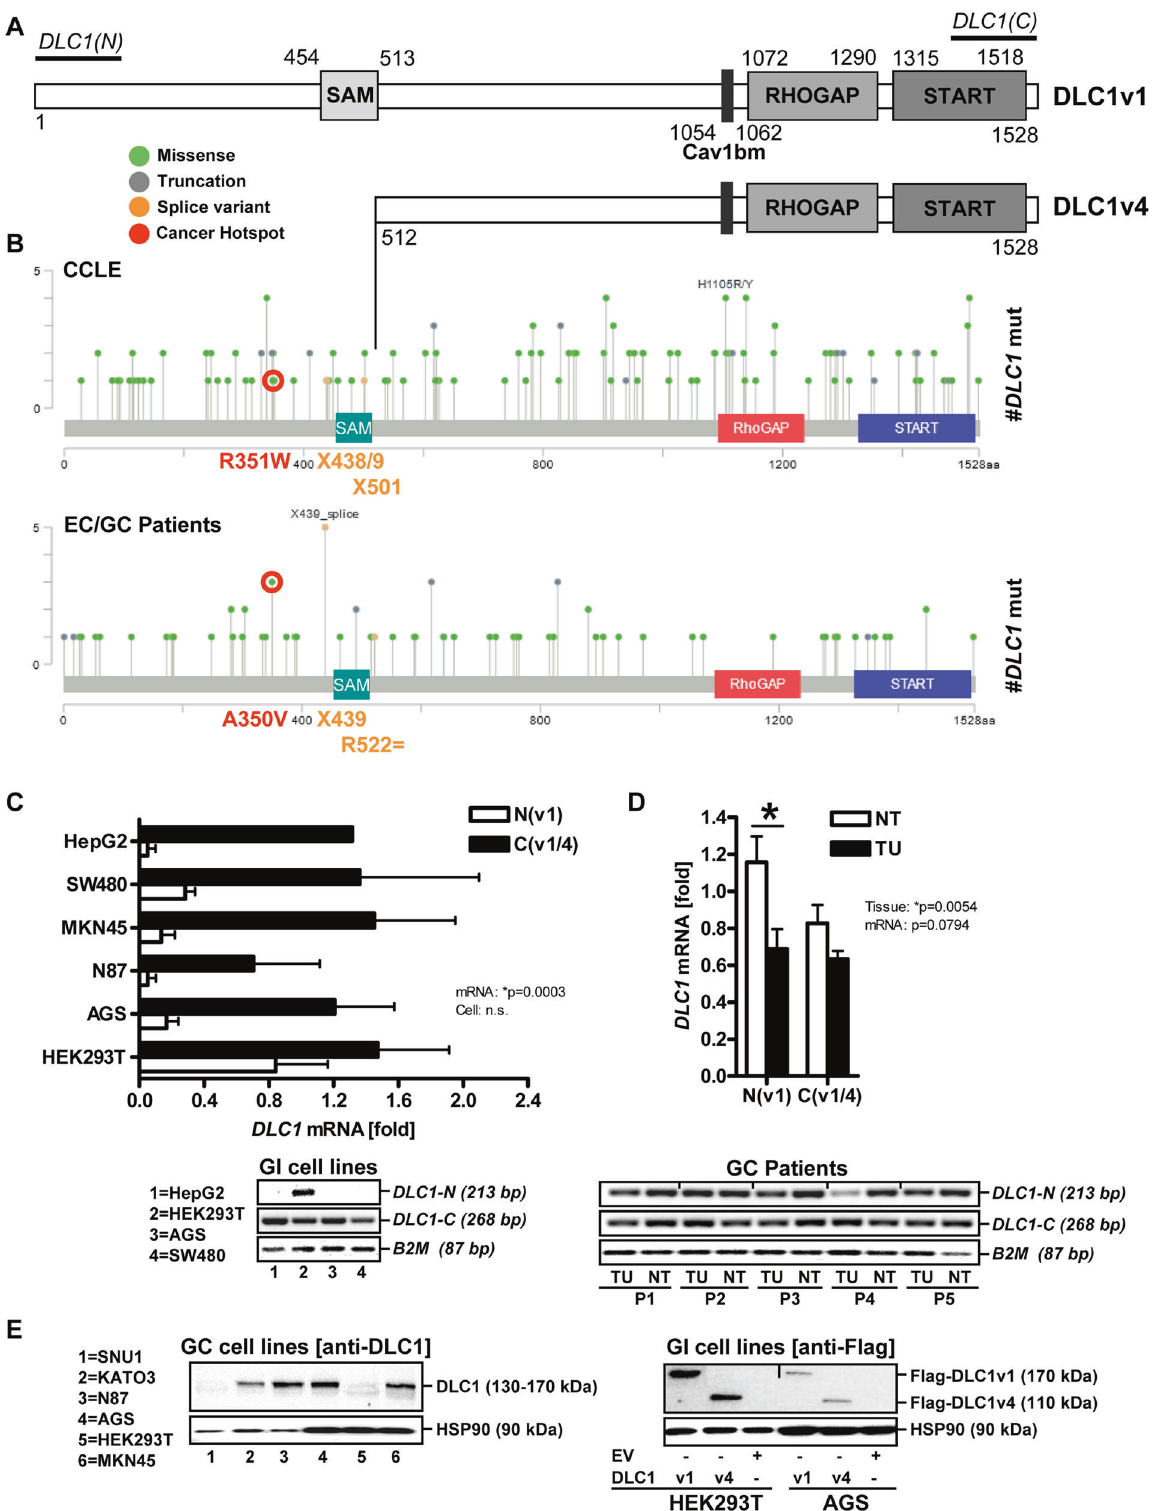
normalised to total cell counts were increased (HEK293T: * p < 0.05 vs. EV, 2way-ANOVA with Bonferroni post-tests, n = 3 per cell line). DLC1 was localised to the periphery of spread-out cells and in focal adhesions (DLCv1) or neurite-like extensions (DLC1v4), whereas CagA was targeted to the plasma membrane and promoted needle-like cell elongations ( “ humming bird ” ). In